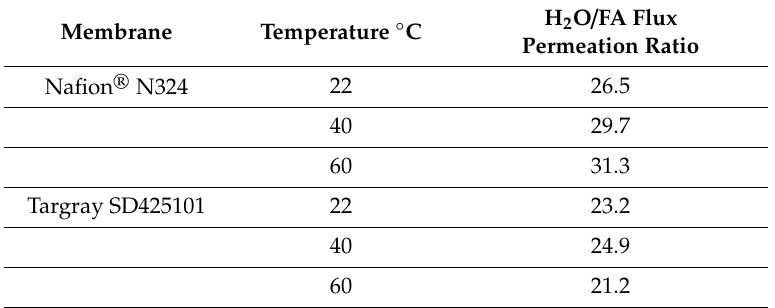
Table 3. Water and FA mass permeation flux ratios for Nafion ® N324 and Targray SD425101.